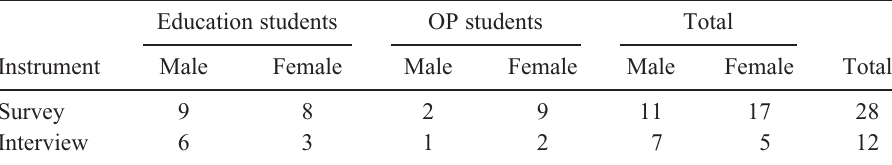
Table 3. Respondents’